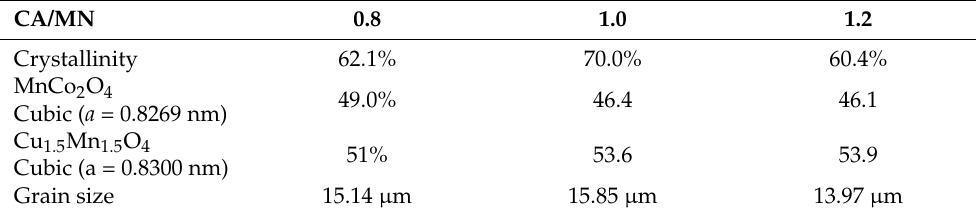
( c ) Figure 7. Microstructure of the pelletized CMC spinel sintered at 1200 °C using spinel powders synthesized at CA/MN ratios of ( a ) 0.8, ( b ) 1.0, and ( c ) 1.2.